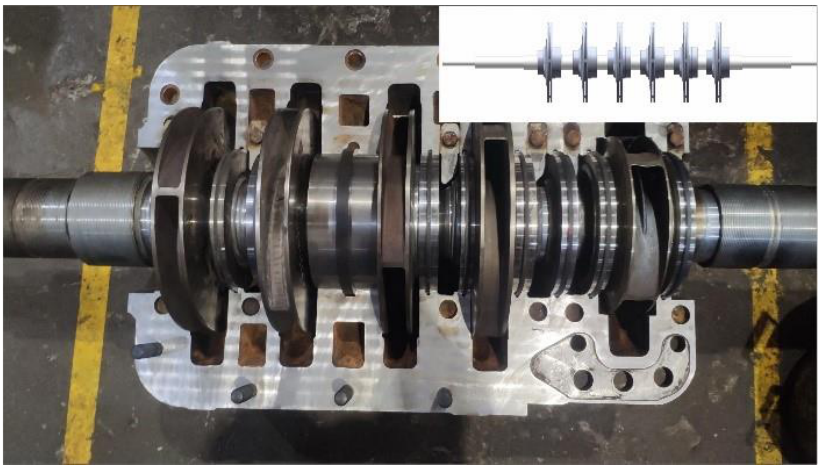
Figure 1. Structure of a real multi-stage centrifugal pump.